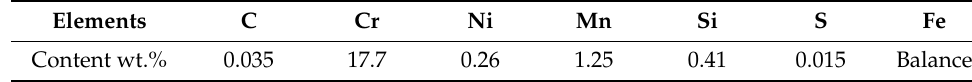
Table 2. Chemical composition of the stainless steel ball.